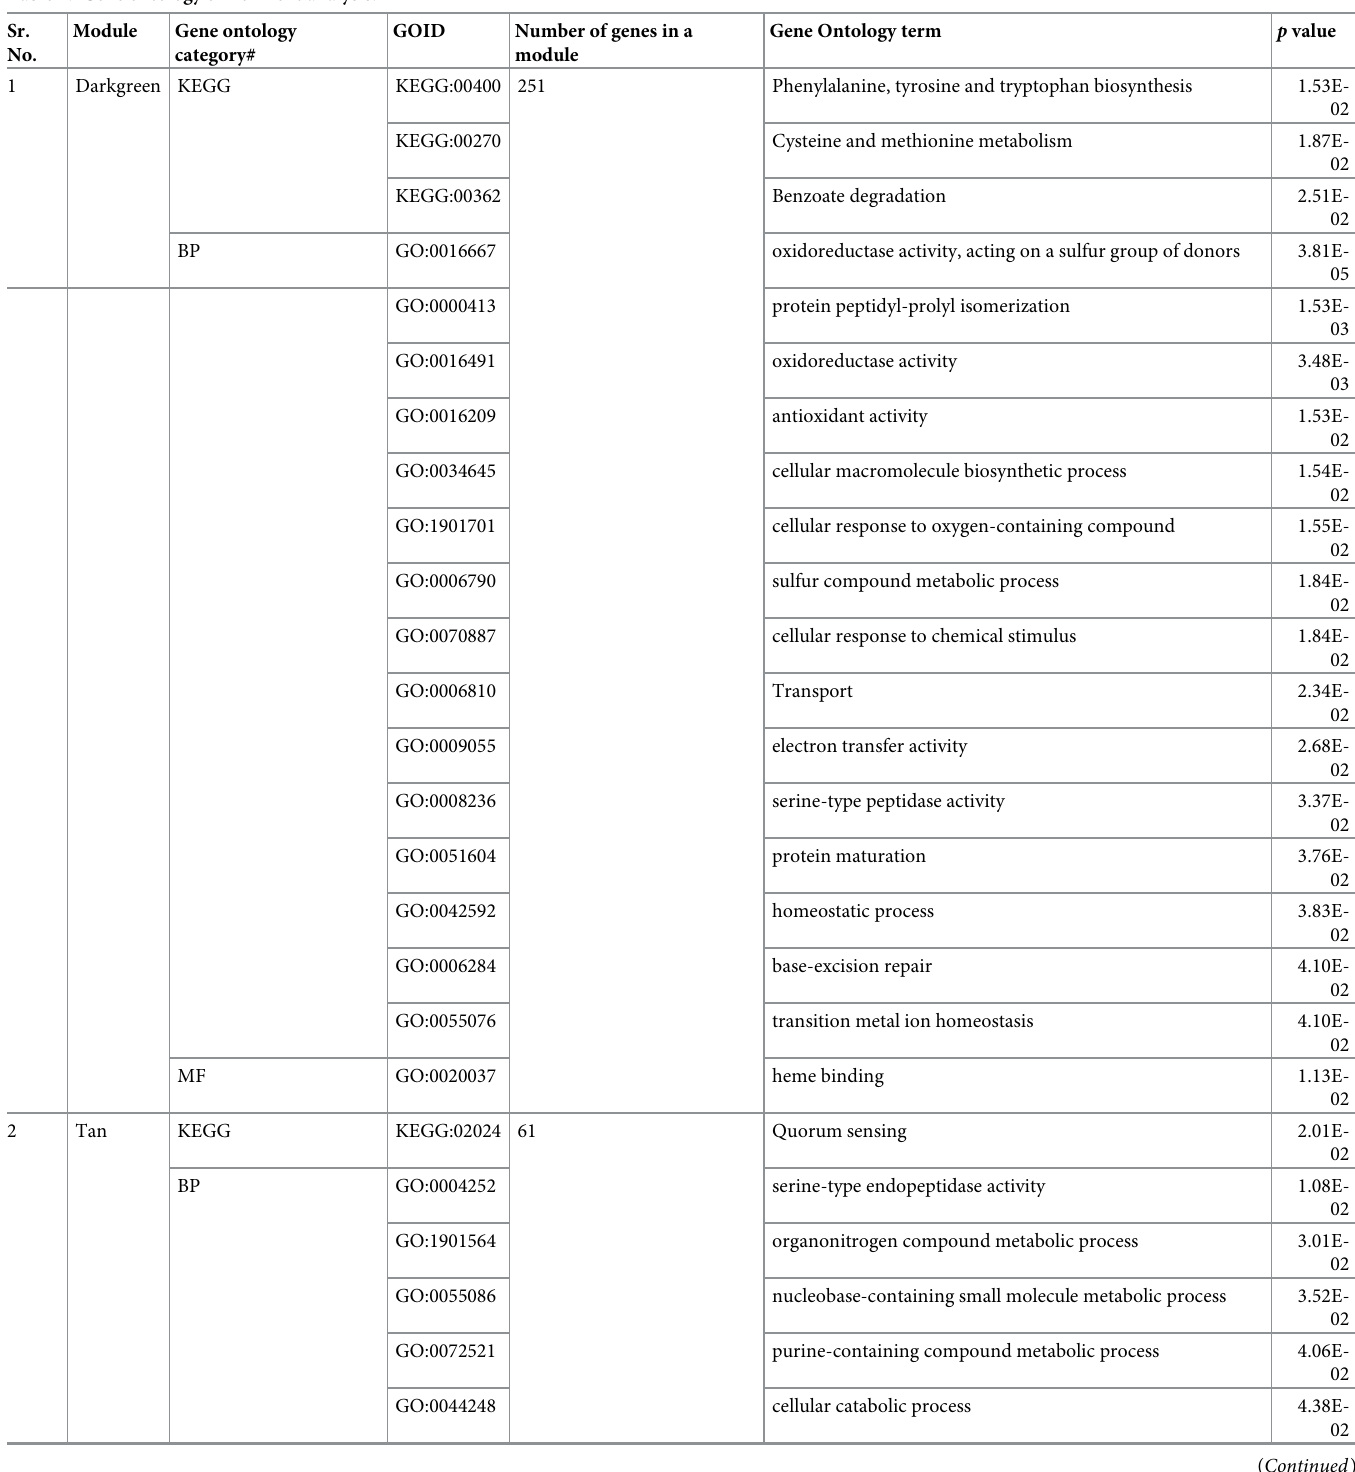
Table 1. Gene ontology enrichment analysis. Sr.